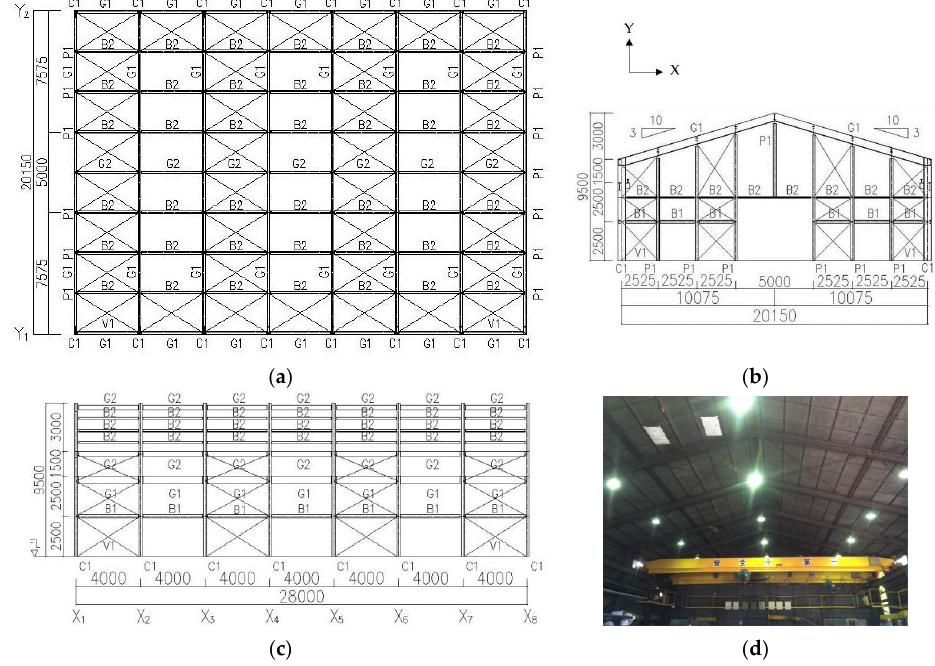
Figure 1. ( a ) Plan; ( b ) elevation ( x -axis); ( c ) elevation ( y -axis); ( d ) interior view. Unit: mm. Table 1. The members’ list of the building steel structure.